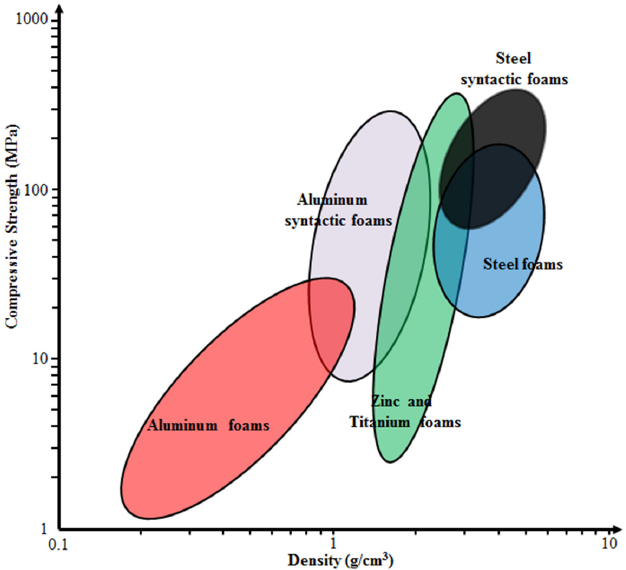
Figure 1. Approximate quantitative comparison of aluminum, titanium, zinc and steel conventional and SFs’ (syntactic foams) compressive strength and density, based on a data collection by Weise et al. [17].